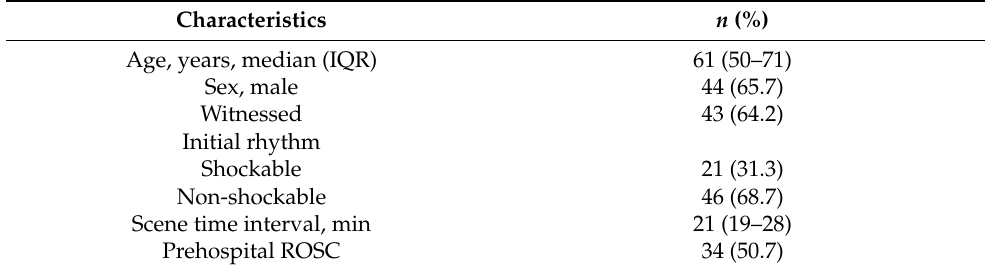
Table 2. Characteristics of patients and events ( n =